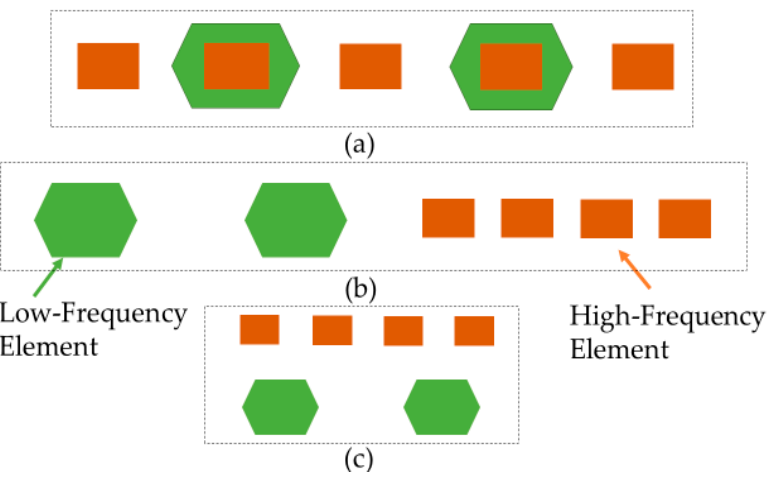
Figure 14. ( a ) Multiband embedded scheme; ( b ) multi band side-by-side scheme; ( c ) multiband up-and-down coaxial scheme [2].